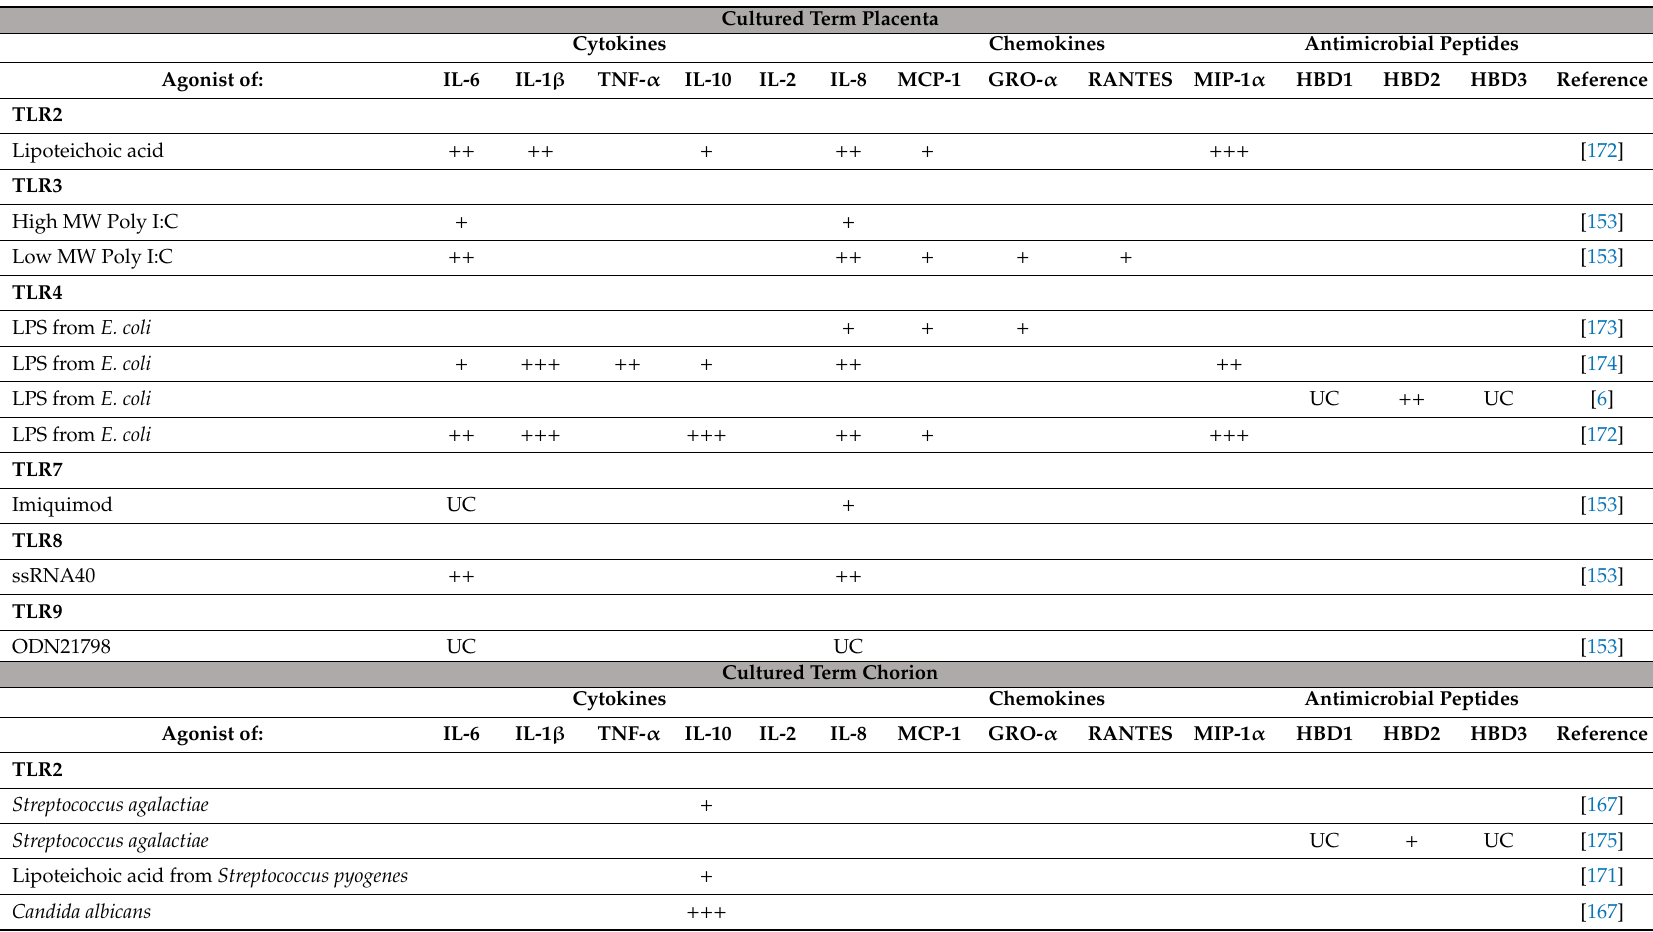
Table 2. Cytokines, chemokines and antimicrobial peptides modulated by di ff erent TLR agonists in gestational tissues. Cultured Term Placenta Cytokines Chemokines Antimicrobial Peptides Agonist of: